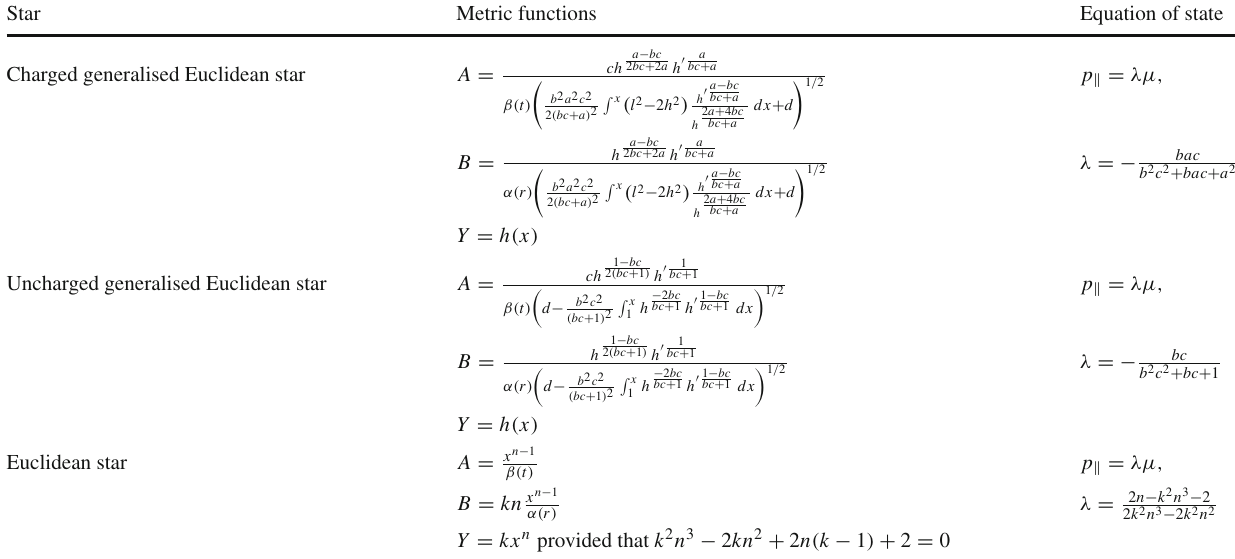
Table 1 Stars, metric functions and equations of state Star Metric functions Equation of state Charged generalised Euclidean